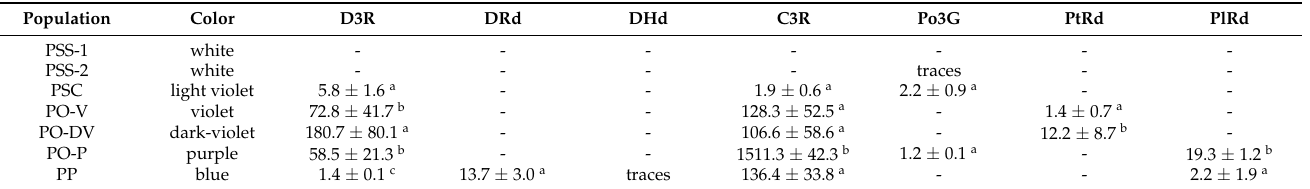
Table 3. Anthocyanin content (mean ± SD, in mg/g FW) in Phyteuma . Different letters mean statistical differences between populations for each